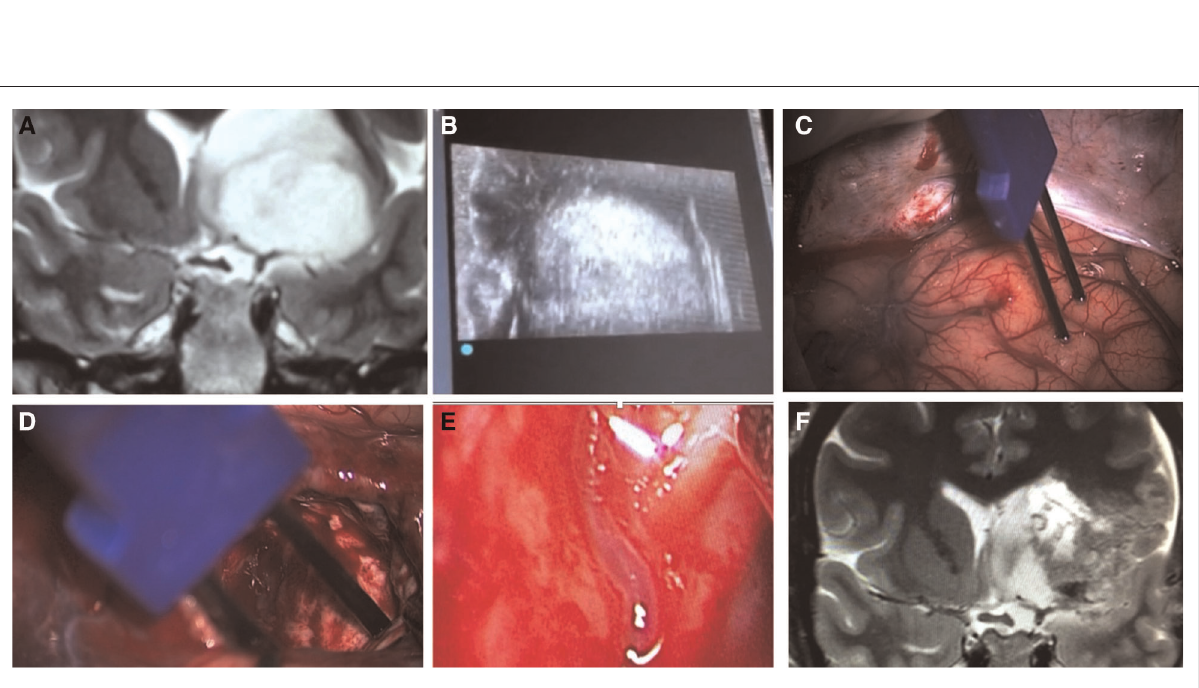
FIGURE 15 A case of insular glioma treated with LSTa as a resection limit. A - coronal T2-weighted MRI showing left-sided insular glioma with extension over the OC-IR line, suggesting a high probability of LSTa tumoral encasement; B - intraoperative echography as a tool to delineate the subcortical tumoral location; C - cortical brain mapping; D - subcortical brain mapping; E - intraoperative view of the LSTa within the tumor; F - postoperative MRI showing residual tumor beyond the OC-IR line, as it was the medial resection